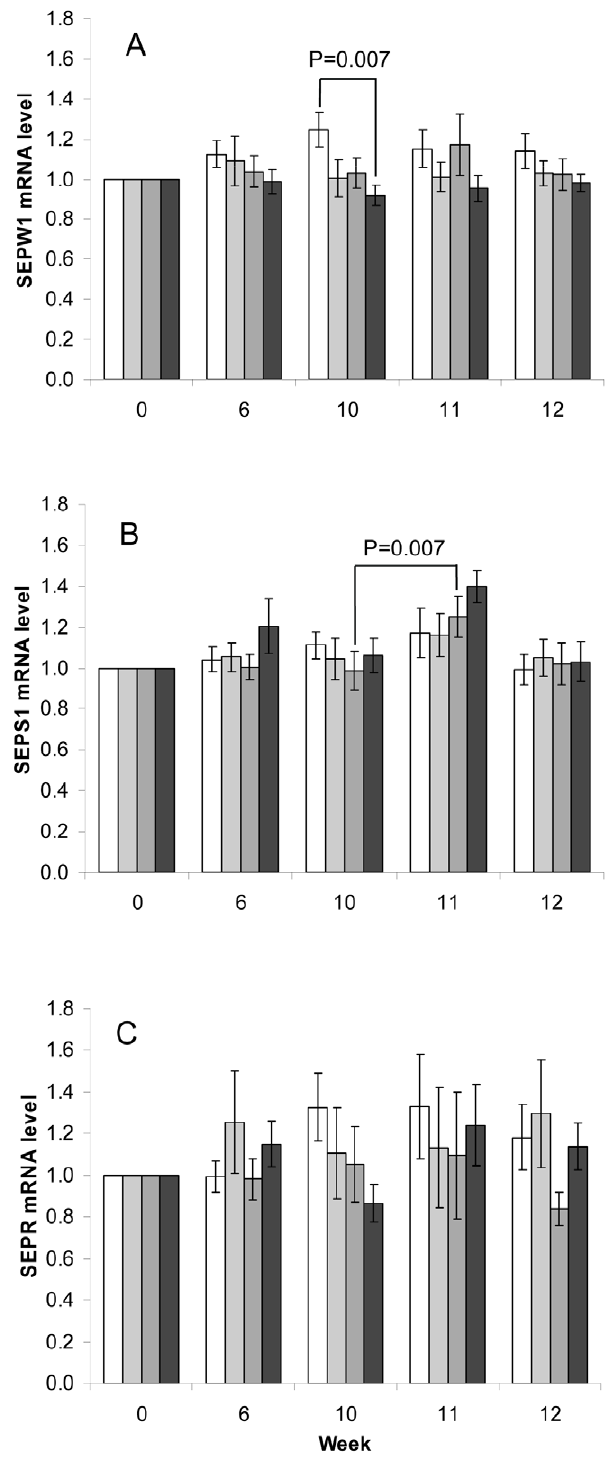
Figure 2. mRNA level in PBMCs measured over the duration of intervention period for (A) SEPW1, (B) SEPS1, (C) SEPR in the placebo and Se-yeast groups. Values are means 6 SEM relative to baseline, week 0 expression. GUSB was used as reference gene for normalisation. White bars = placebo group (n=14 to 20); light grey bars = 50 m g/day Se-yeast (n=11 to 15); mid grey bars = 100 m g/day Se-yeast (n=10 to 19); black bars = 200 m g/day Se-yeast (n=14 to 18). The variation in sample number (n) between time points for each treatment is due to insufficient RNA at some sampling time points and